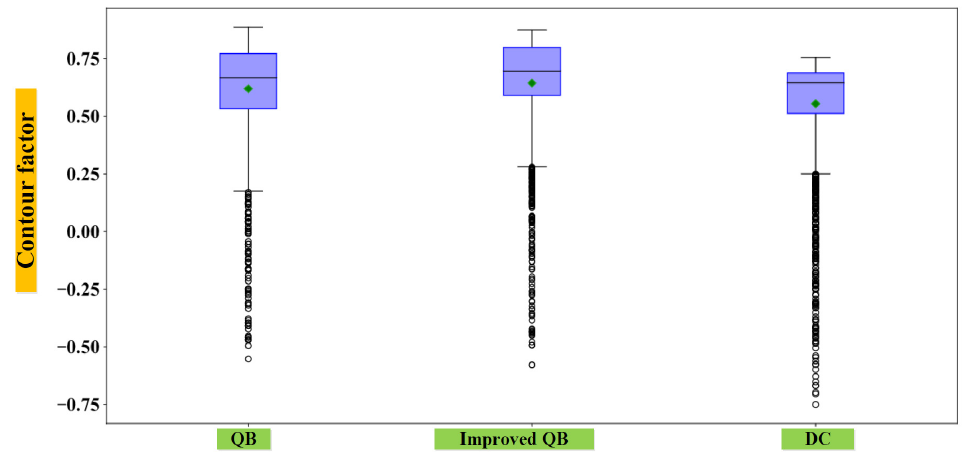
Figure 16. Box diagram of ship trajectory profile coefficients in the three algorithms.